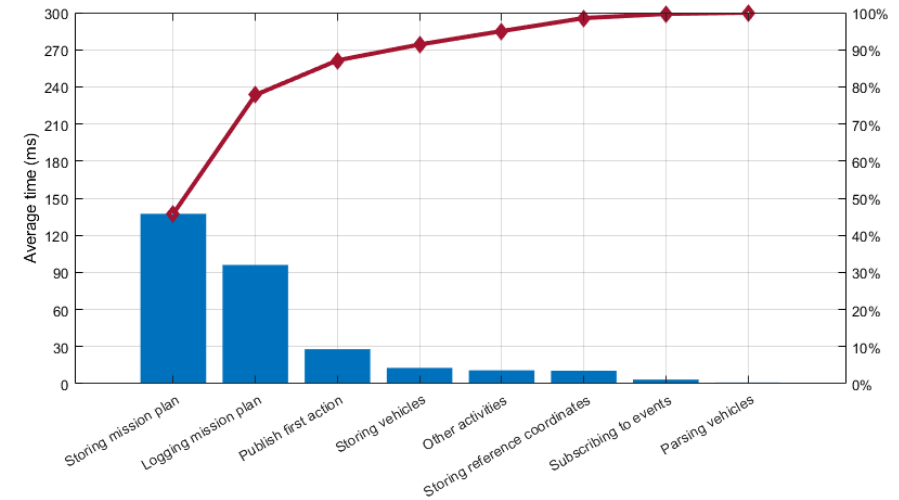
Figure 29. Pareto chart for the average distribution of time for each activity performed by the MTRR when starting a mission.